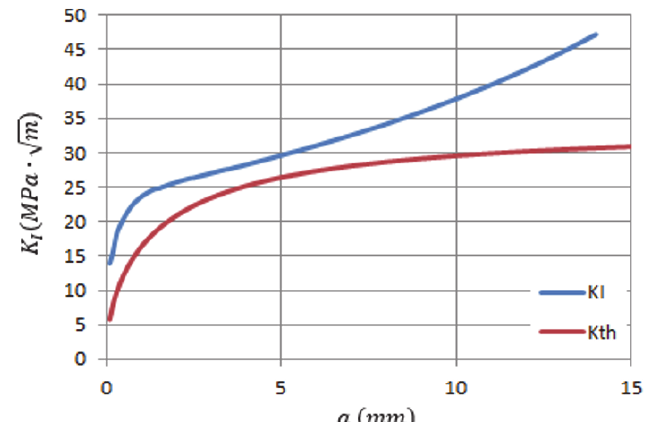
Figure 6: Curves K I (a)  a and K EACth (a)  a generated by the analysis of the linear elastic DC(T) under EAC and P  8250N .